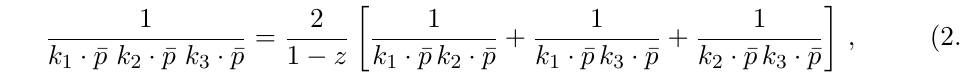
Figure 2. The collinear projection of the squared scattering amplitude for the process q and the process q